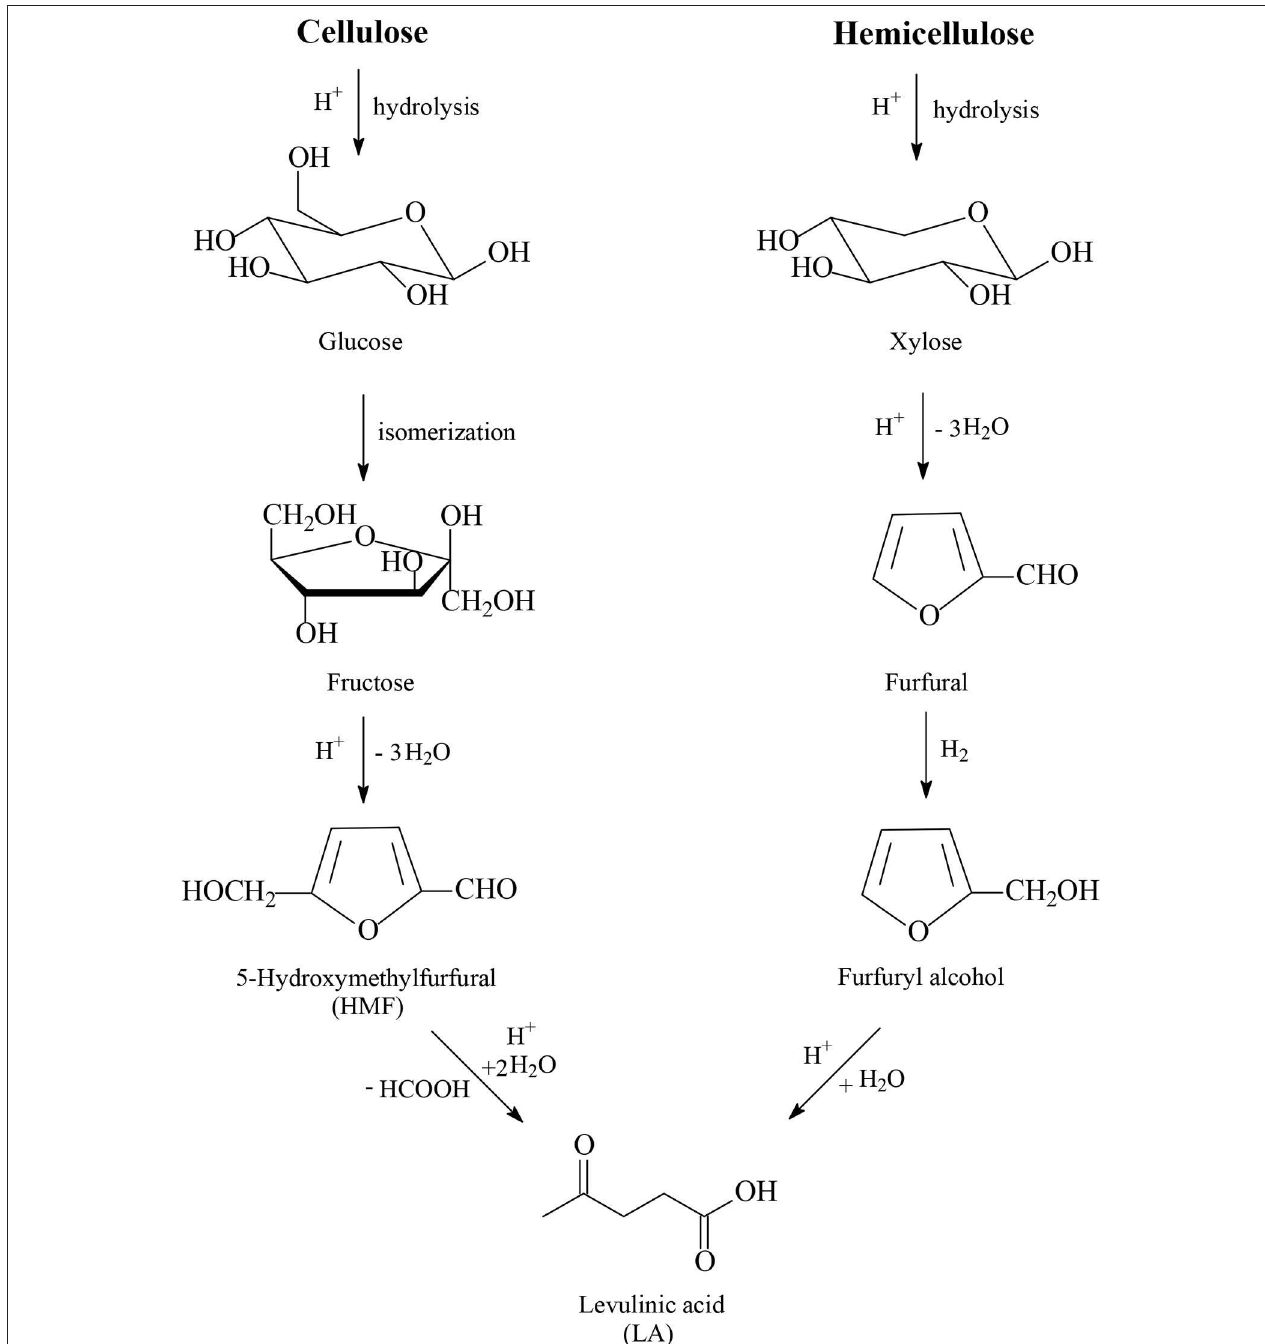
FIGURE 1 | Production routes of levulinic acid from cellulose and